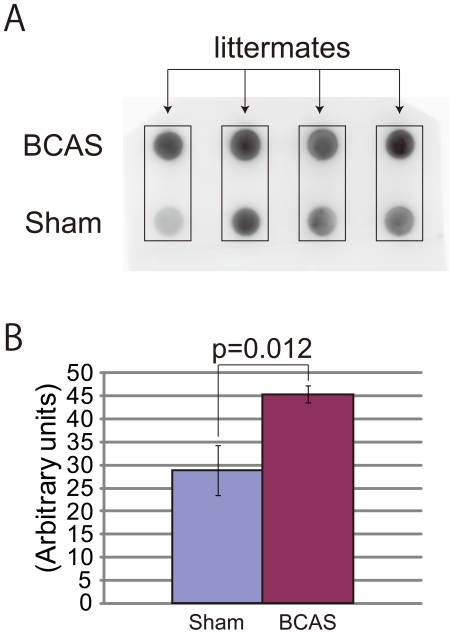
Chronic cerebral hypoperfusion increased filter-trap Aβ in the extracellular-enriched, soluble brain fraction.(A) Filter-trap, Aβ-immunoreactive spot density was increased in samples from BCAS-treated mice, compared to sham-operated littermates. (B) Spot density was significantly increased in BCAS-treated mice (paired t-test; p = 0.0231, n = 4).